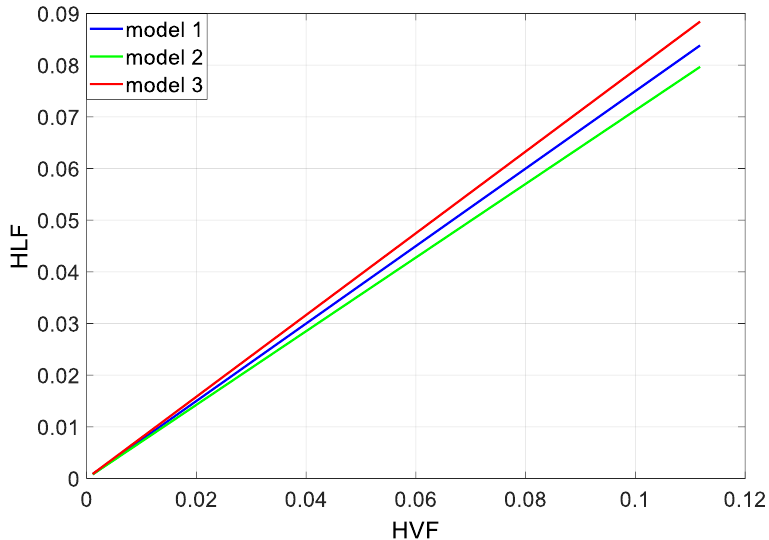
Figure 6. The HLF values as a function of the HVF values for the tested motor, for U s 5 = 0÷0.25 U sN .